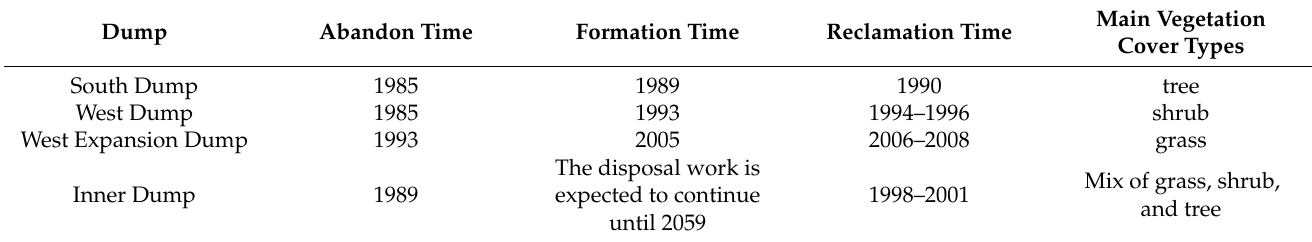
Table 1. Basic information of the four dumps.